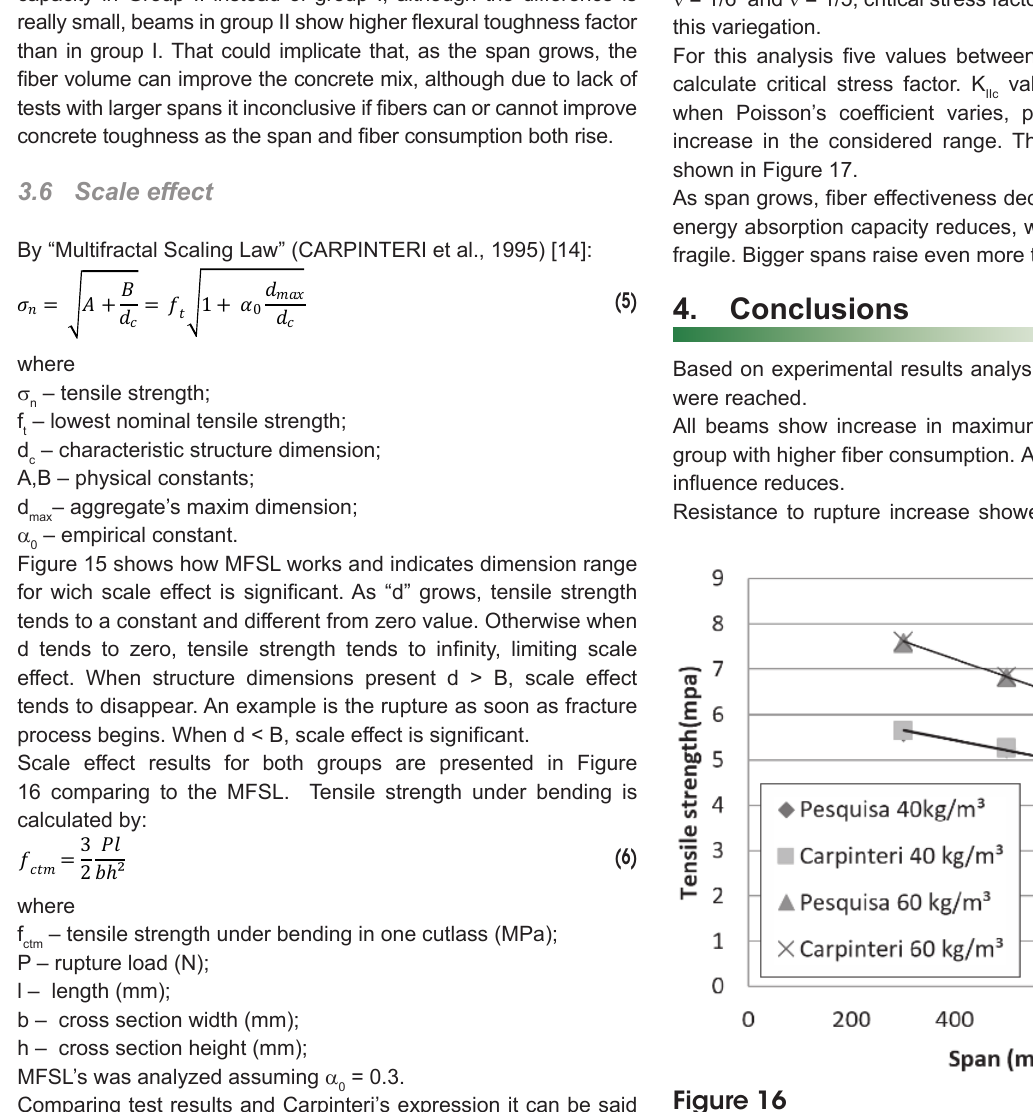
MFS law x research’s results for 40 kg/m³ and 60 kg/m³ fiber